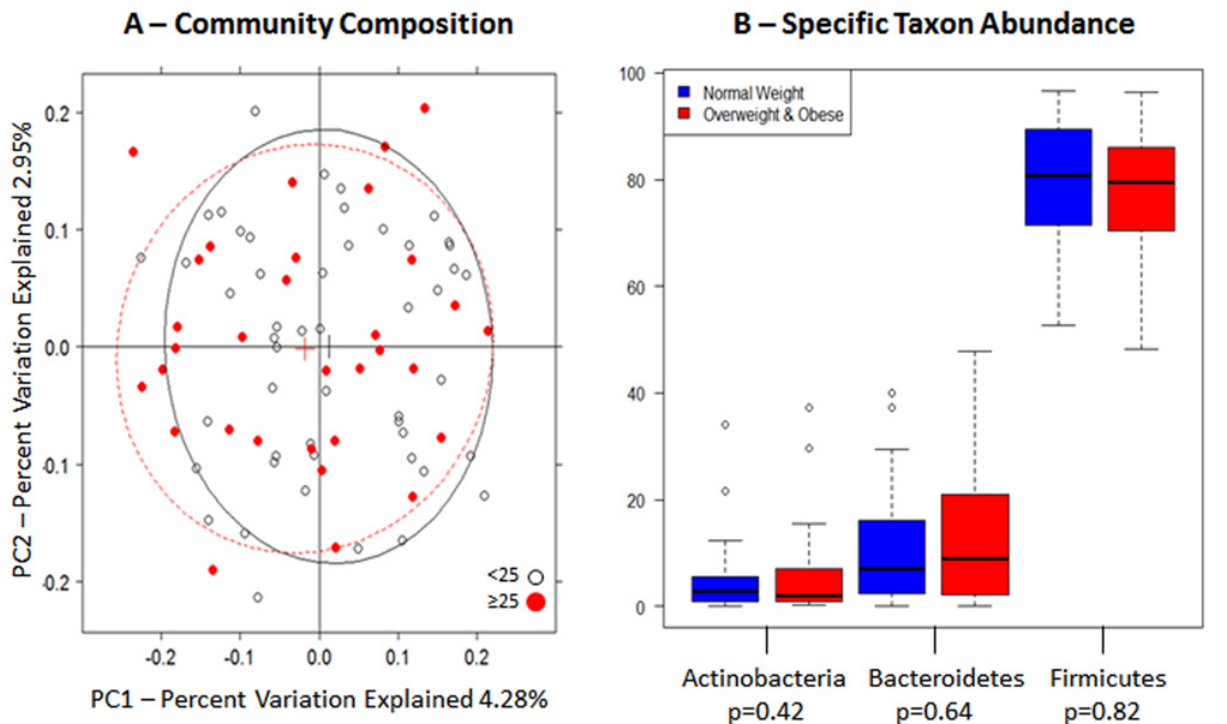
Fig 2. Gut microbiome according to BMI. (A) Unweighted principal coordinate analysis plot of the first two principal coordinates categorized by BMI ( < 25 kg/m 2 , (cid:3) 25 kg/m 2 ). Ellipses were added to plots using the R package, latticeExtra (R version 2.15.3). (B) Relative abundance of the three major phyla. Mann- Whitney-Wilcoxon test was used to test for overall differences using SAS software (version 9.3). Nominal p-values are listed below each phylum.